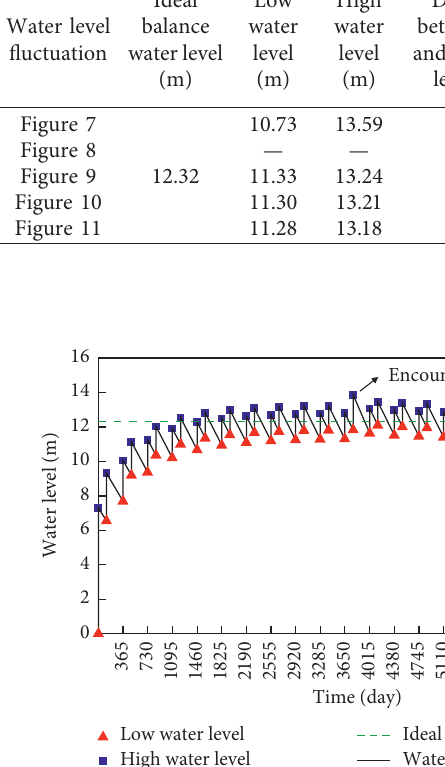
Figure 12: Water level fluctuation of the reservoir encountering frequency flood in the 10th year.